Question: Draft a figure caption describing what is shown.
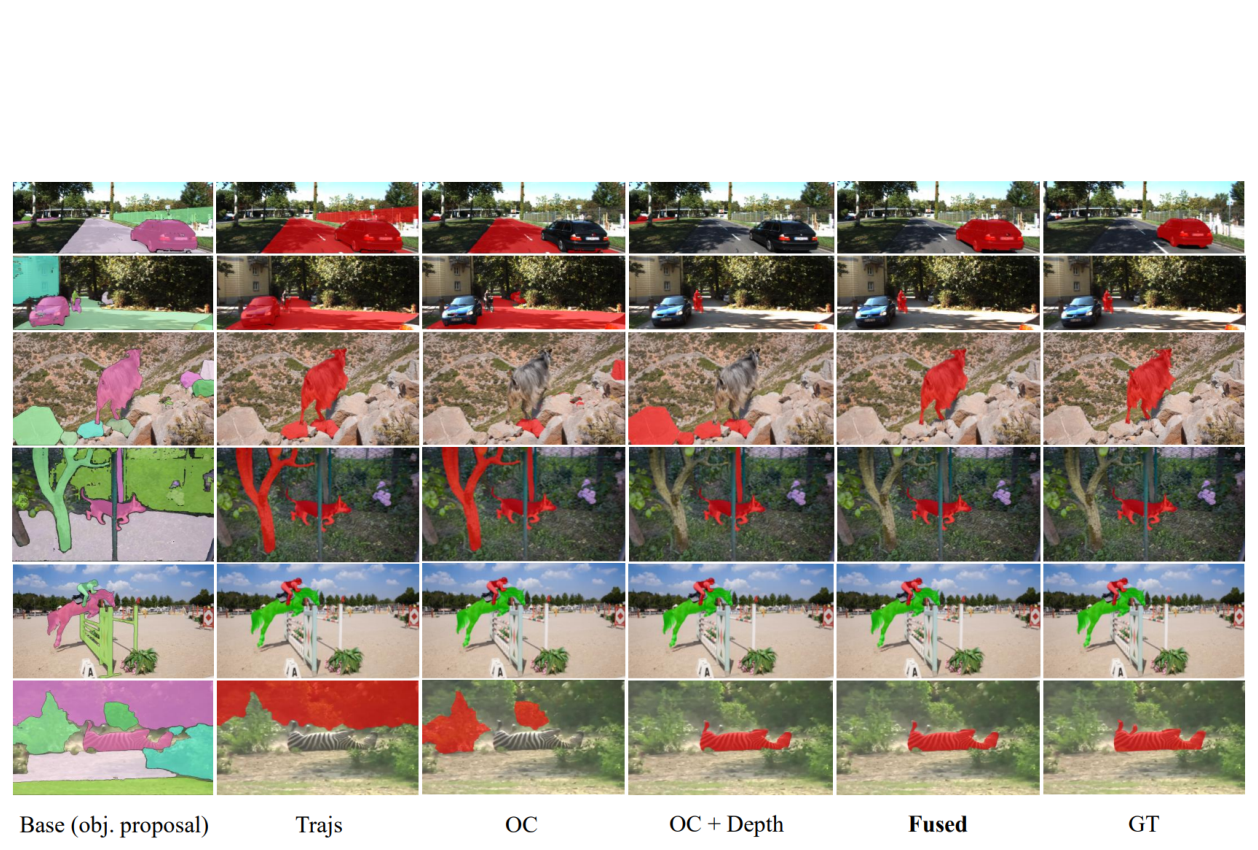
Answer: Qualitative comparison of different motion models on different scenes. Pure optical flow based motion model (OC) suffers on scenes with objects at varying depths. Combining optical flow with depth information (OC + Depth) only alleviates this problem to some extent. Pure point trajectory based motion model (Trajs) suffers from motions near the epipolar plane and inaccurate trajectory estimation. Motion model fusion solves these problem by combining the advantages of both motion models and outperforms any single model.